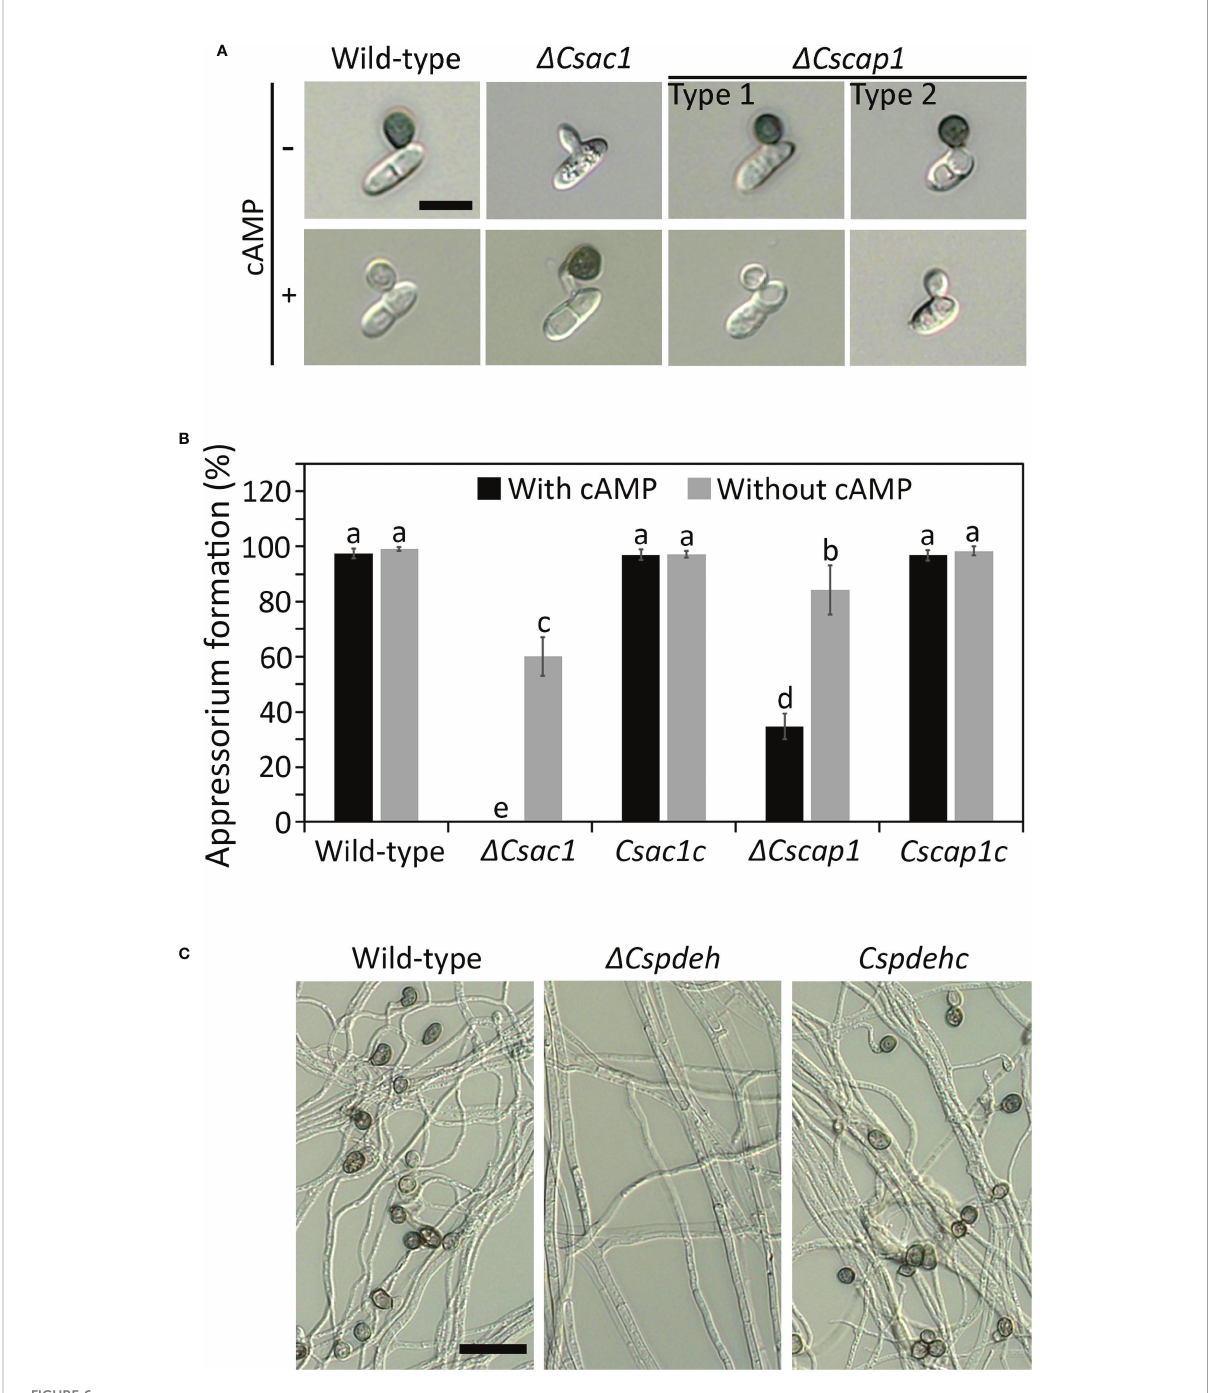
FIGURE 6 Roles of CsAc1 , CsCap1 , and CsPdeH in appressorium formation. (A, B) Appressorium developed by conidia of D Csac1 and D Cscap1 . (A) Conidial suspensions (5 × 10 4 /mL) were dropped onto the hydrophobic surface of coverslips. After 12 hours, exogenous cAMP (2.5 mM) was added to conidial drops and incubated for 12 hours. Scale bar, 10 m m. (B) Quantitation of appressorium formation by conidia (n = 100 conidia). (C) Appressorium-like structure formation of D Cspdeh . Mycelial agar plugs from 3-day-old OMA cultures were placed on the hydrophobic surface of coverslips and incubated in a humid box for 4 days. Scale bar, 20 m m. Error bars show standard deviations and different letters in the same group indicate signi fi cant differences estimated using Duncan ’ s test (P <